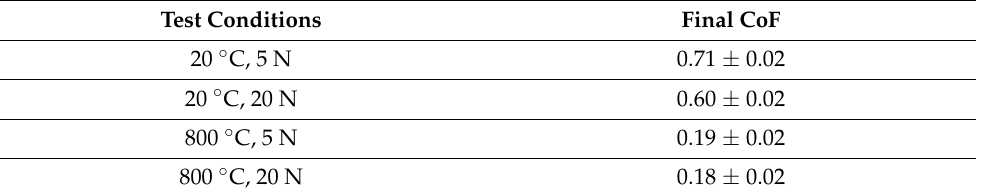
Table 3. Effect of temperature and load on CoF measured at the end of